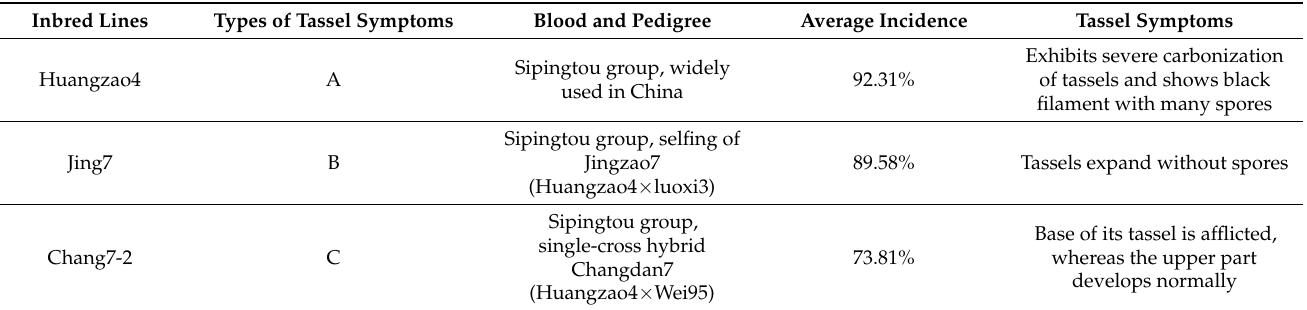
Table 2. Information about three inbred lines with different symptoms affecting the tassels of maize infected with Sporisorium reilianum